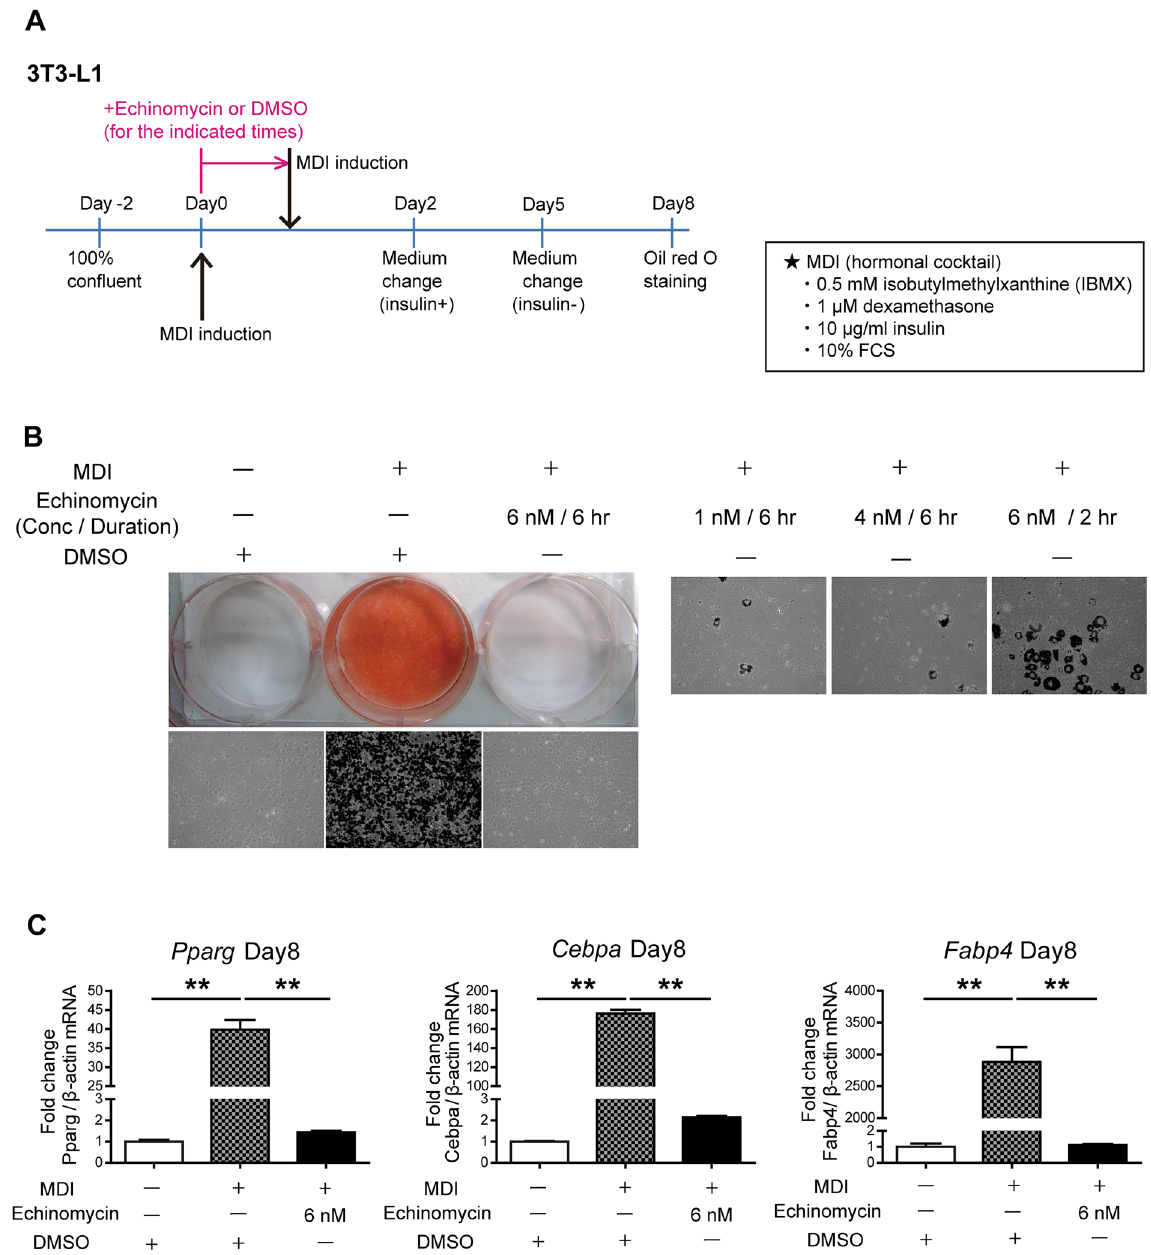
Figure 1. Echinomycin inhibits adipogenesis in 3T3-L1 cells in a time- and dose-dependent manner. ( A ) Protocol for preadipocyte differentiation and echinomycin treatment: two days after 3T3-L1 cells reached full confluence, they were treated with medium containing a differentiation cocktail containing MDI [10% FCS, 3-isobutyl-1-methylxanthine (0.5 mM), dexamethasone (1 μ M), and insulin (10 μ g/ml)] for 2 days, and then, for an additional 3 days, the cells were maintained in DMEM containing 10% FCS and insulin (10 μ g/ml). Echinomycin or DMSO was added to medium with MDI, and after the times (hr) indicated in each experiment, cells were gently washed to remove echinomycin or DMSO, and the medium was exchanged with fresh medium containing MDI. ( B ) Oil red O staining 8 days after induction. ( Left upper panel ) Macroscopic shots of oil red O staining are shown. ( Left lower panel ) 10x white-black converted shots are presented. The red areas in the colour pictures, which correspond to triglyceride lipid droplets, were converted to black areas for easier comprehension. ( Right panel ) Lower concentrations or shorter durations of echinomycin treatment of 3T3-L1 cells result in insufficient adipogenesis inhibition, demonstrated by the same method as left lower panel (20x white-black converted shots of oil red O staining at day 8). ( C ) qRT-PCR analysis of mature adipocyte gene expression in 3T3-L1 cells at day 8. Mature adipogenic genes such as Pparg , Cebpa , and Fabp4 were induced by MDI and suppressed by echinomycin treatment. The data are expressed as the mean ± SEM from three independent experiments. ** P < 0.01, as determined by one-way ANOVA with Tukey’s